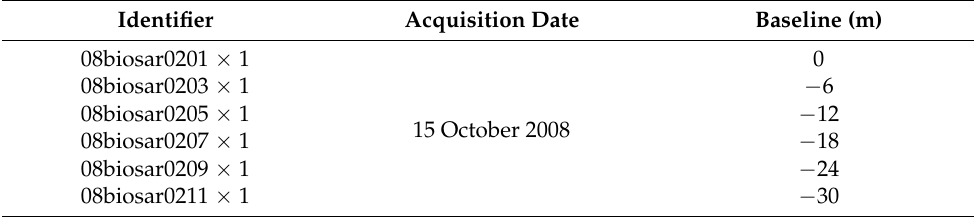
Table 3. The baseline information for the InSAR pairs